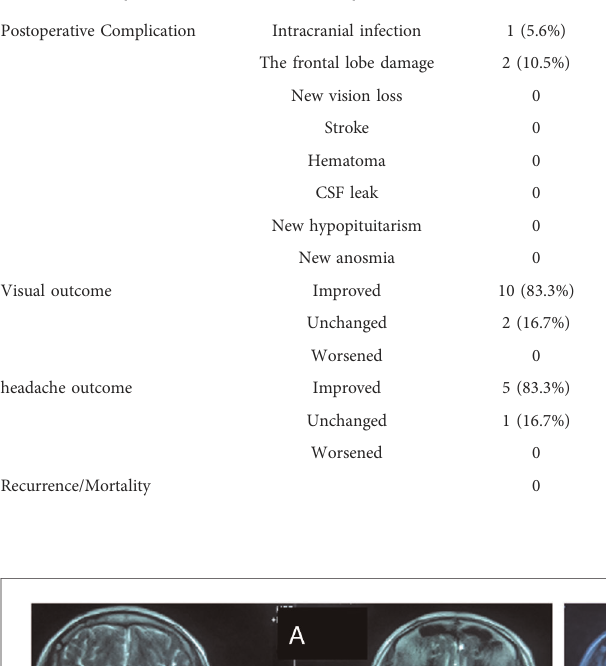
TABLE 3 Postoperative conditions of TSM